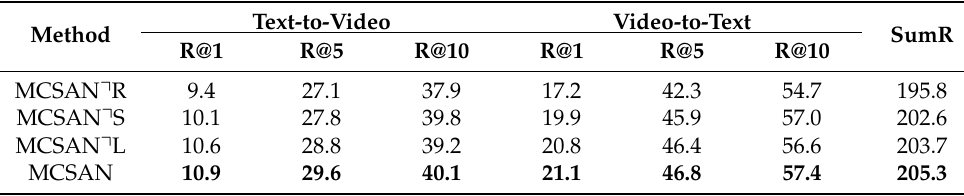
Table 3. Results of comparison among different variants in MCSAN on MSR-VTT dataset. The best performance are marked in bold. MCSAN exploiting all the four semantic levels (global, entity, action and realtionship) is the